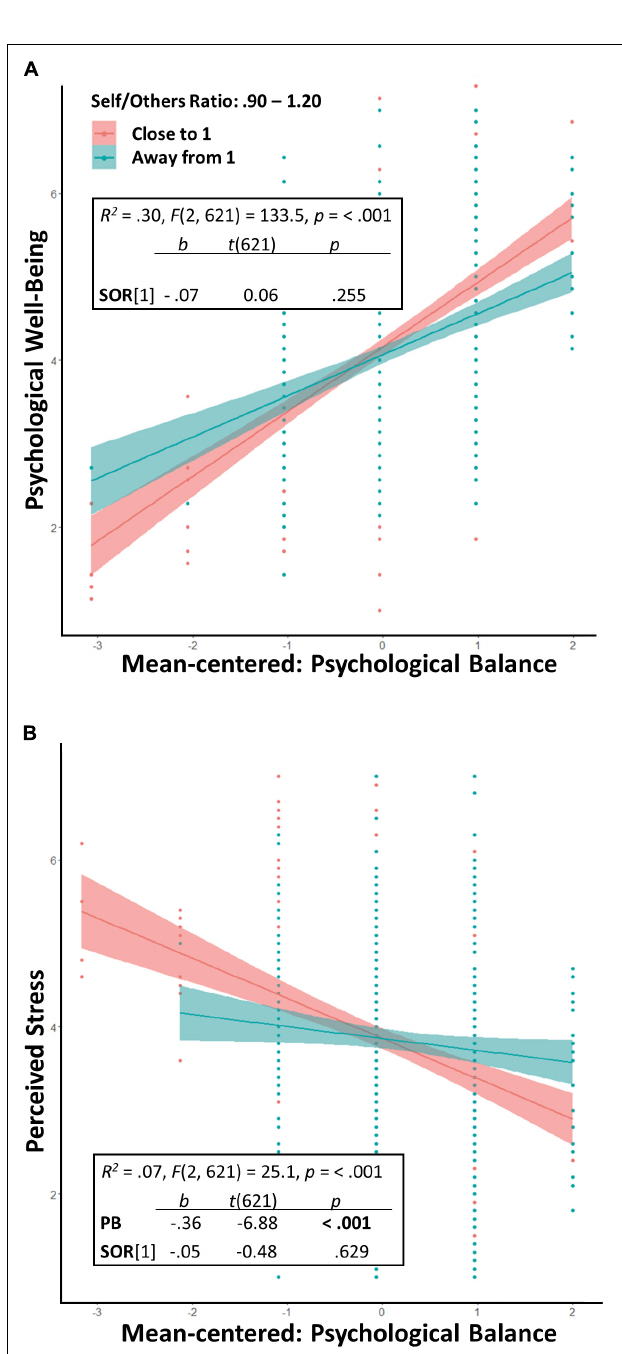
FIGURE 6 | Study 3: (A) Self/Others Ratio as a positive moderator in the relationship between Psychological Balance and Psychological Well-Being. (B) Self/Others Ratio as a negative moderator in the relationship between Psychological Balance and Perceived Stress.